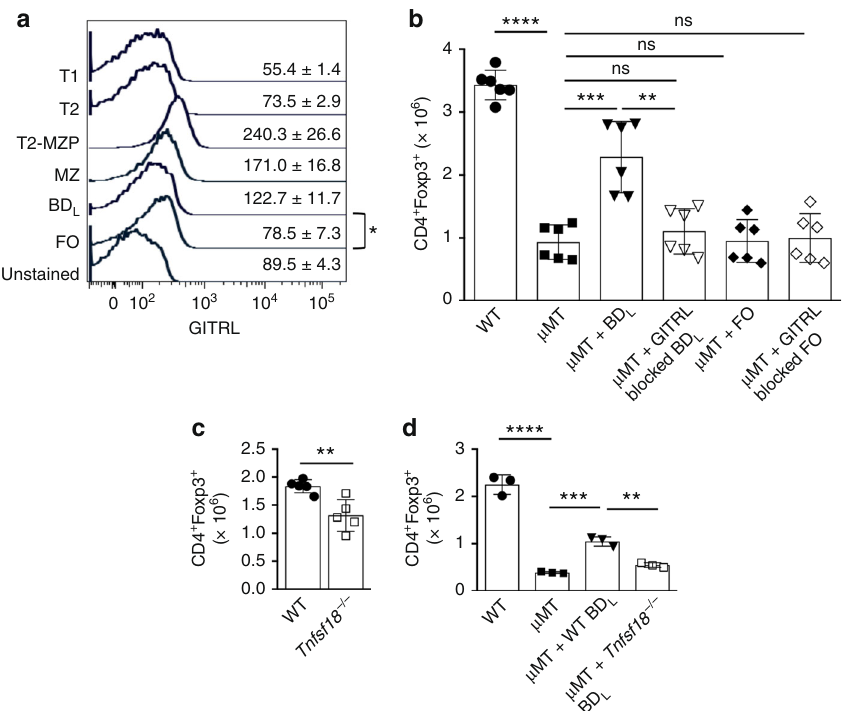
Fig. 5 BD L regulatory activity is GITRL-dependent. a Splenic T1, T2, T2-MZP, MZ, BD L , and FO B cells from B10.PL mice expressing GITRL was determined by fl ow cytometry. The data shown are the MFI ± SEM of three mice from one of four independent experiments. * p < 0.05, BD L vs. FO B cells. b – d C57BL/ 6 μ MT mice were reconstituted with 5 × 10 6 FACS-puri fi ed WT BD L ( b , d ), WT FO ( b , d ), Tnfsf18 − / − (GITRL − / − ) BD L ( d ) cells from C57BL/6 mice with ( b ) or without ( d ) GITRL antibody blocking and the absolute number of splenic Treg was determined by fl ow cytometry 10 days later. c Treg were quantitated in the spleen of WT and Tnfsf18 − / − mice by fl ow cytometry. b Individual data points (mice) are shown superimposed upon the mean ± SEM from two independent experiments. ** p < 0.01, μ MT + WT BD L vs. μ MT + GITRL blocked WT BD L ; *** p < 0.001, μ MT vs. μ MT + WT BD L ; **** p < 0.0001, WT vs. μ MT. c Individual data points (mice) are shown superimposed upon the mean ± SEM of fi ve mice. ** p < 0.01. d ** p < 0.01, μ MT + WT BD Tnfsf18 − / −